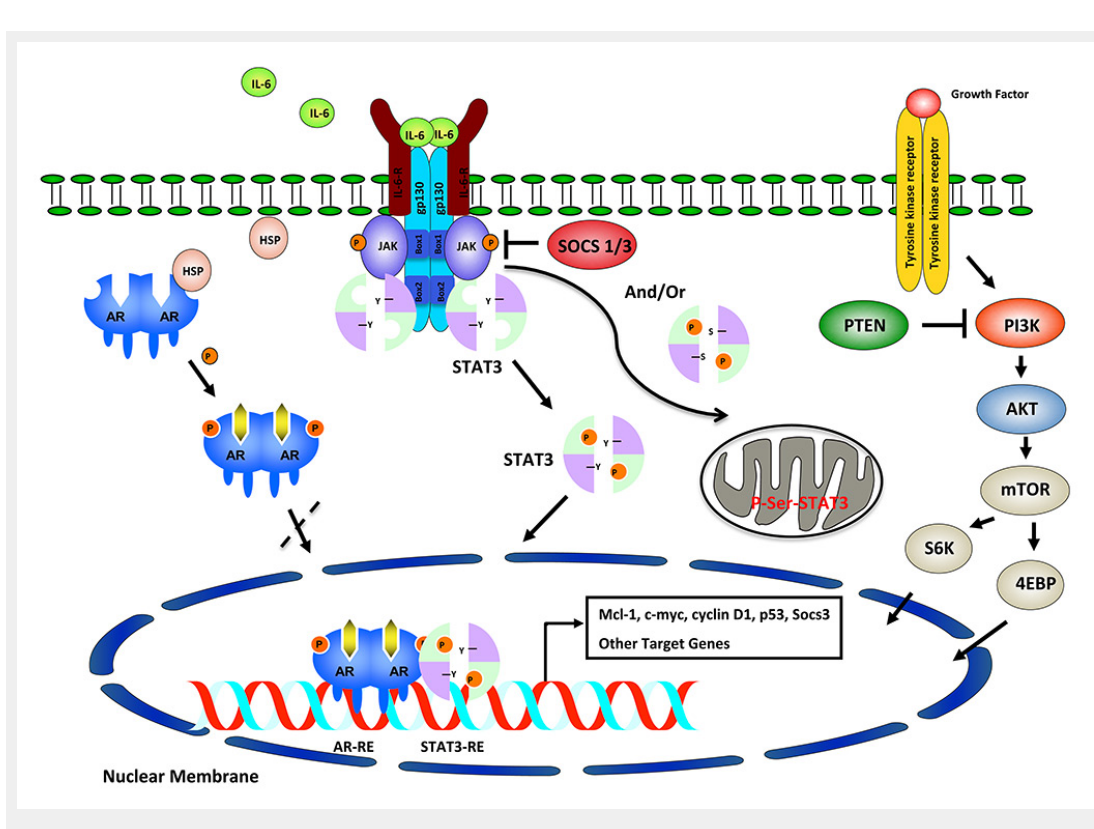
Figure 1 Overview of IL-6/STAT3/ARF and PI3K/PTEN/AKT/mTOR pathways. Activation of IL-6/STAT3 signalling leads to phosphorylation and translocation of STAT3 to the nucleus, which is associated with AR interaction regulated by HSP. JAKs serve to phosphorylate tyrosine (Y) or serine (S) residues of STAT3 and to translocate to nucleus or mitochondrial matrix. Some of these downstream signalling events (STAT3-AR- S6K) could regulate activity or expression of prostate cancer related genes. ARF = alternative reading frame protein; IL-6 = interleukin-6; PI3K = phosphatidylinositol-3-kinase; PTEN = phosphatase and tensin homologue; STAT3 = signal transducer and activator of